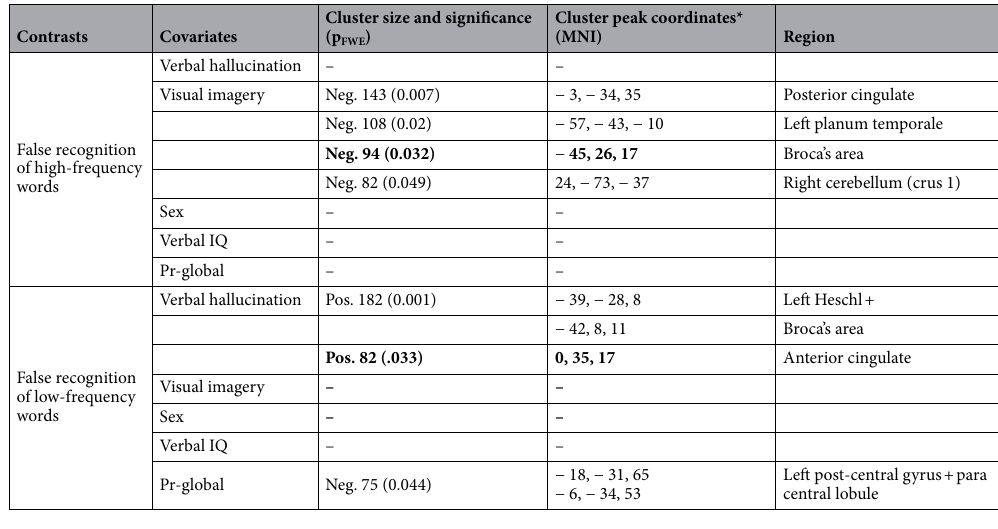
Table 2. Brain activation areas significantly associated with each covariate (verbal hallucination proneness, visual imagery, sex, verbal IQ, and Pr-global) during the false recognition of high- and low-frequency words in the 37 participants. MNI MNI stereotactic coordinates, p FWE family-wise error corrected p -value, * Peak-level corrected significance p FWE < .05 marked in bold coordinates.